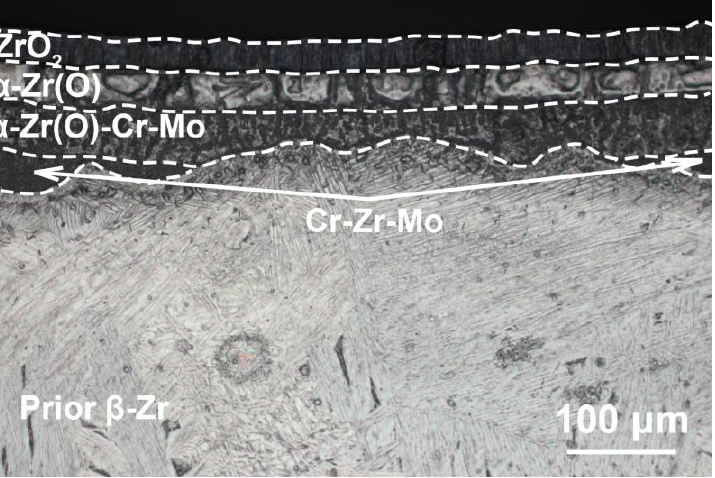
Figure 6. Cross-section optical micrograph of the Cr/Mo-coated Zr alloy sample after oxidation at 1400 °C for 120 s.